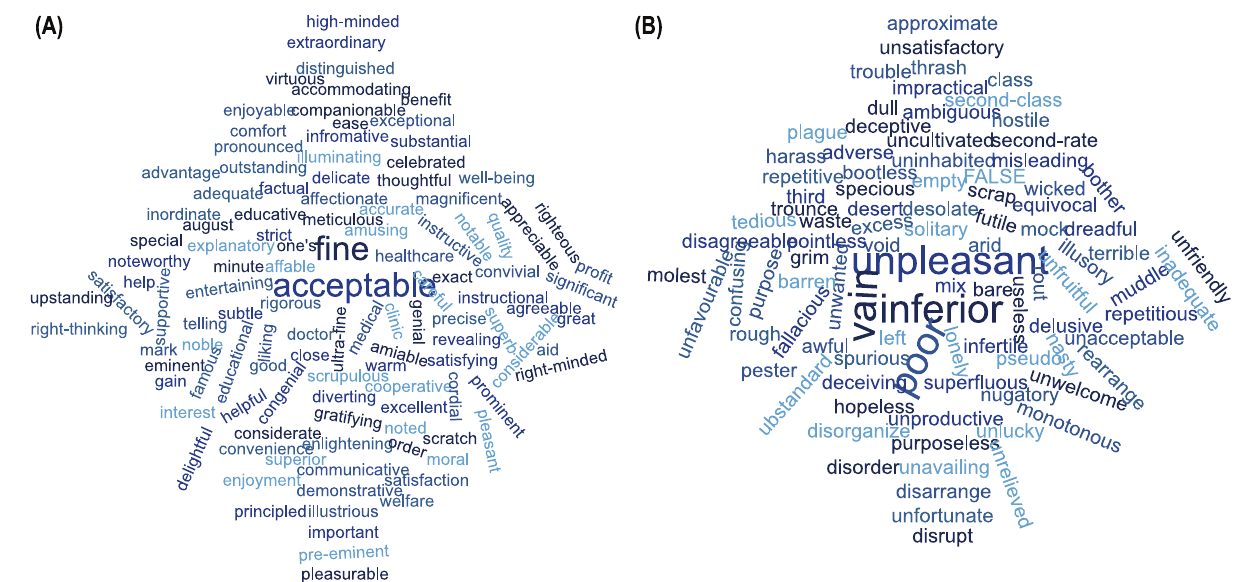
Fig 5. Word cloud for Polarity of words found in the comments of selected apps– (A) positive polarity words, and (B) negative polarity words.